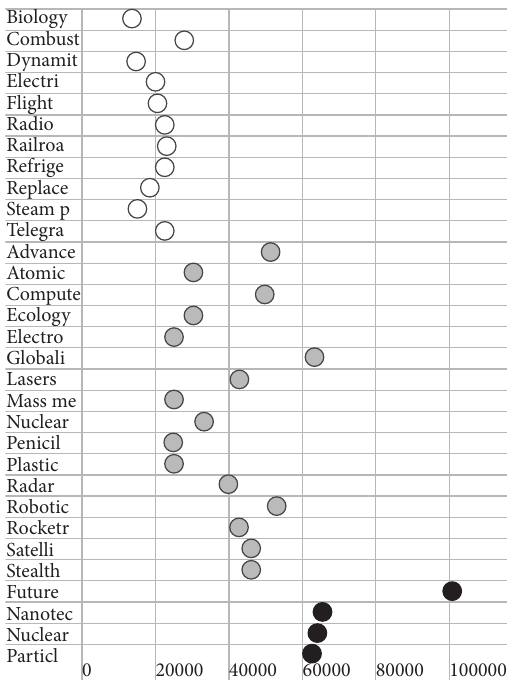
Figure 7: Minimum science requirements for the technologies of the last three eras in Civ 5, as plotted by TTT. (In order to improve the image quality for publication, the figure was redrawn based on a TTT screen capture.) Distinct techs are represented on their corresponding rows, and the horizontal locations of circles (their midpoints) represent the OC values of the corresponding techs. OC values increase linearly along the horizontal axis from left to right, as indicated.